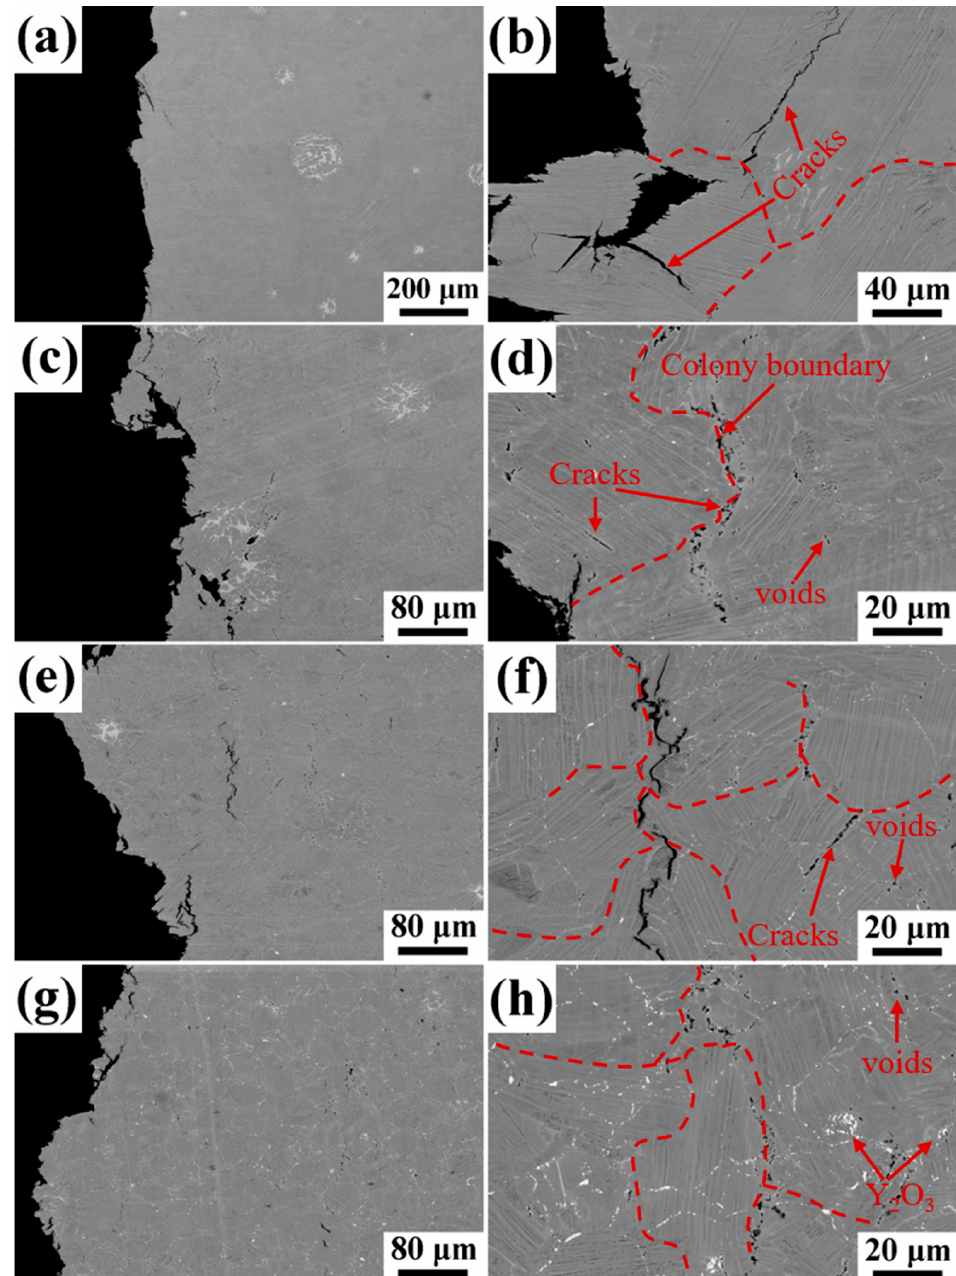
Figure 8. Fracture side face after tensile test at 900 °C: ( a , b ) 0 at%; (c , d ) 0.05 at%; ( e , f ) 0.10 at%; ( g , h ) 0.20 at%.